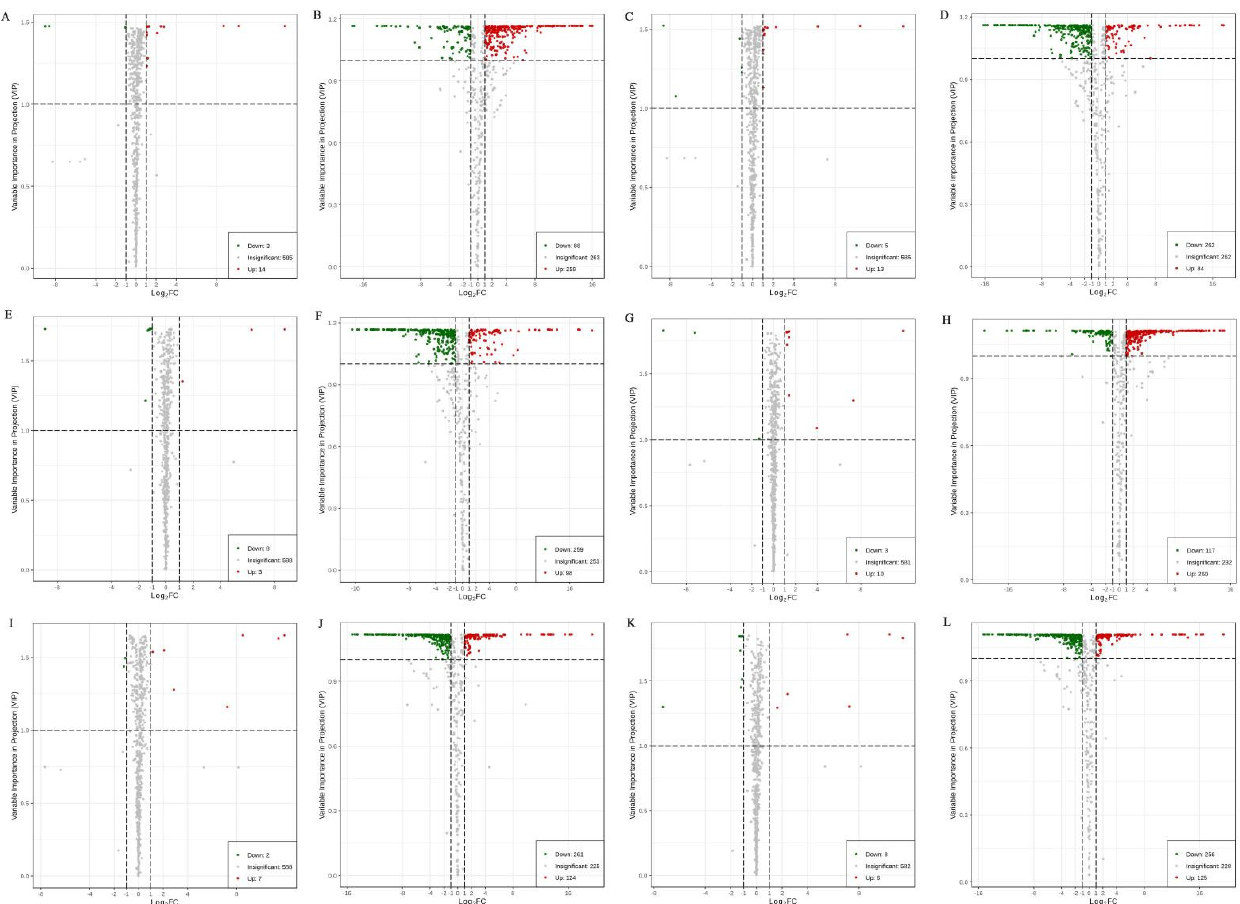
Figure 4. The volcano plots show the content levels of primary metabolites in the different storage methods of G1 and G2. (A–F): in G1. ( A ): T1-V vs. T1-A, ( B ): T2-A vs. T2-V, ( C ): T1-V vs. T2-V, ( D ): T1-A vs. T2-A, ( E ): T1-A vs. T2-V, and ( F ): T1-V vs. T2-A. ( G – L ): in G2. ( G ): T1-V vs. T1-A, ( H ): T2-A vs. T2-V, ( I ): T1-V vs. T2-V, ( J ): T1-A vs. T2-A, ( K ): T1-A vs. T2-V, and ( L ): T1-V vs. T2-A.